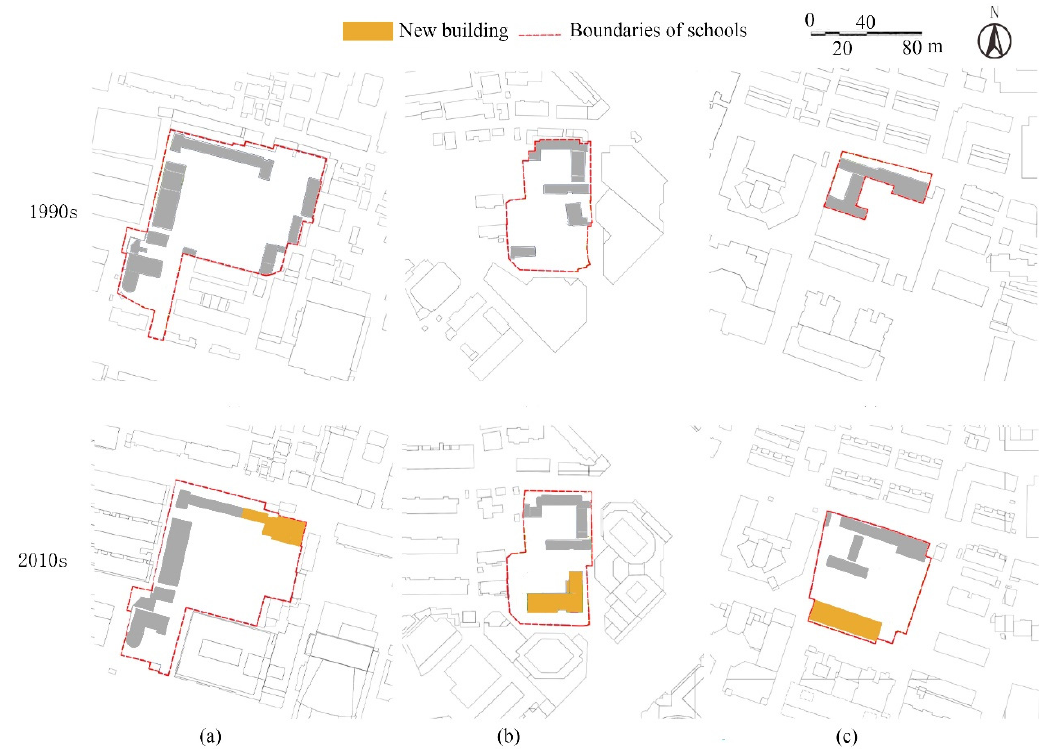
Figure 3. Floor plan of three schools in the 1990s and 2010s. ( a ) Changjiang Road Primary